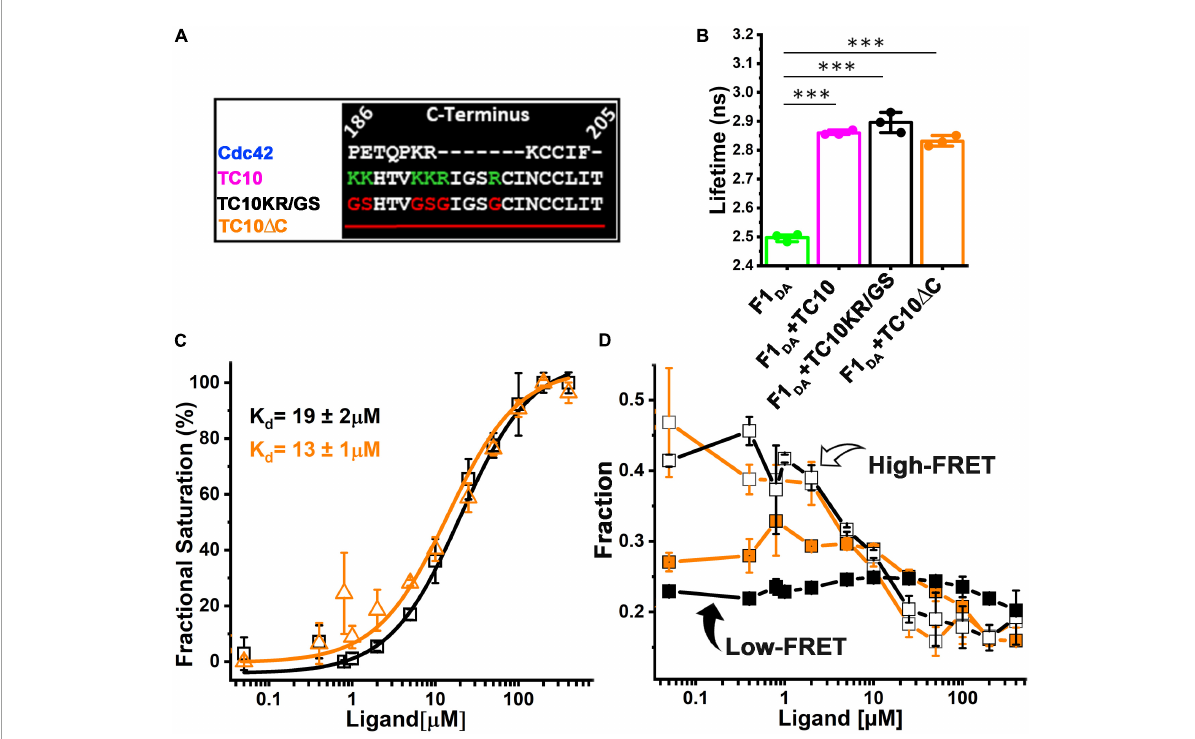
FIGURE3 CB binding affinity for TC10 and variants impaired in phosphoinositide-binding. (A) Alignment of the C-terminal residues of Cdc42 and TC10 (wild-type and variants). In the TC10KR/GS variant the basic residues K and R (shown in green) were replaced with G and S (red). In case of TC10 (cid:49) C, the C-terminal amino acid stretch was completely removed. (B) Bar plots depicting the species-weighted average CFP fluorescence lifetime of F1 DA alone (green) and in the presence of a 100-fold molar excess of TC10 (magenta), TC10KR/GS (black), or TC10 (cid:49) C (orange). ∗∗∗ P < 0.001. (C) F1 (cid:49) C (orange). Affinities were determined by first converting (cid:104) τ (cid:105) into the DA binding affinity plot of TC10KR/GS (black) and TC10 fractional saturation using Equation 4 and the data were further fitted with Equation 5. TC10KR/GS and TC10 (cid:49) C binding affinity for F1 DA were measured as 19 ± 2 µ M and 13 ± 1 µ M, respectively. Data from three individual biological replicates ( n = 3) are presented as mean values ± SD. (D) High-FRET state and low-FRET species composition plotted against increasing concentrations of TC10KR/GS (black) and TC10 (cid:49) C (orange)